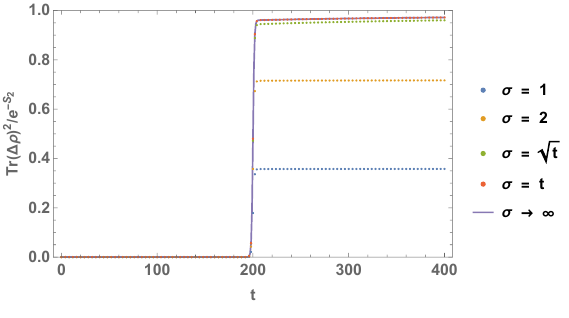
Figure 3 . The contribution of Tr (∆ ρ ) 2 to e − S 2 for different values of σ and N = 400 , Q = 0